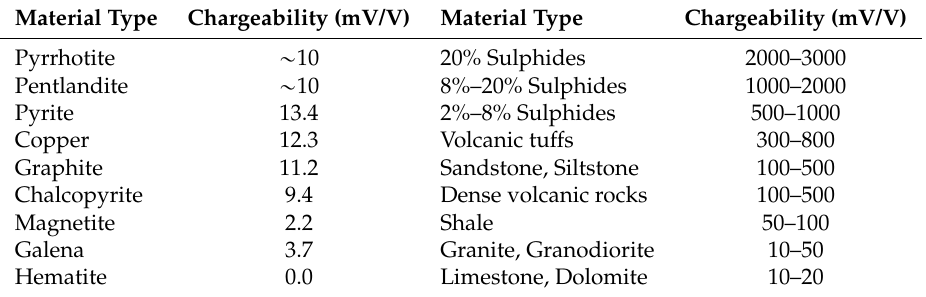
Table 1. Table of indicative chargeability values for various types of ore minerals and rocks measured in laboratory experiments. Modified after